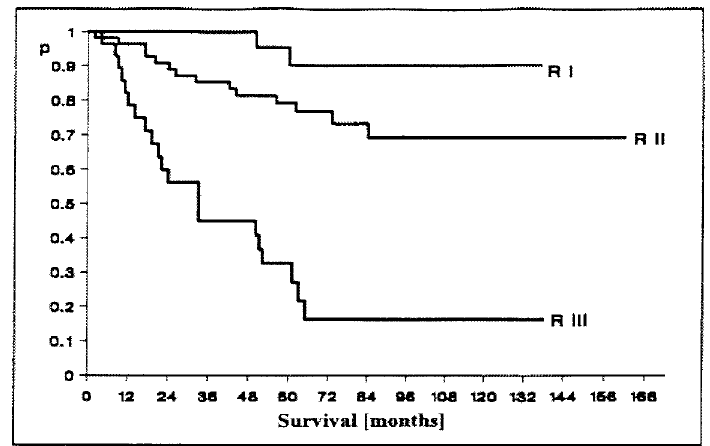
Fig. 3. Survival rates by risk groups. Significantly better survival was in the low risk RI-subgroup ( n = 28) as compared to the intermediate risk RII-subgroup ( n = 56), and in the intermediate risk RII-subgroup as compared to the high risk RIII-subgroup ( n = 28) ( P < 0 . 05 and P < 0 . 001,